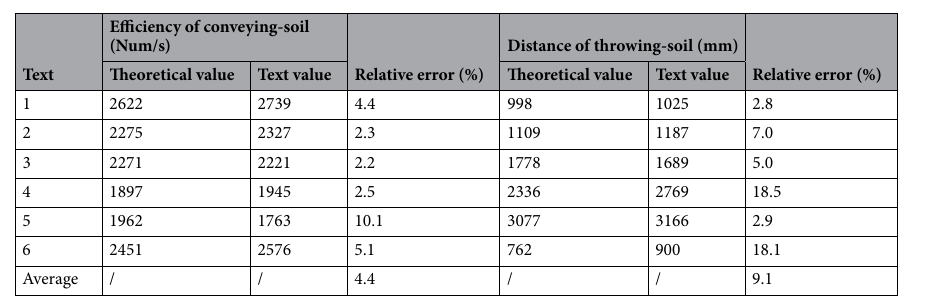
Table 7. Results and comparison of validation